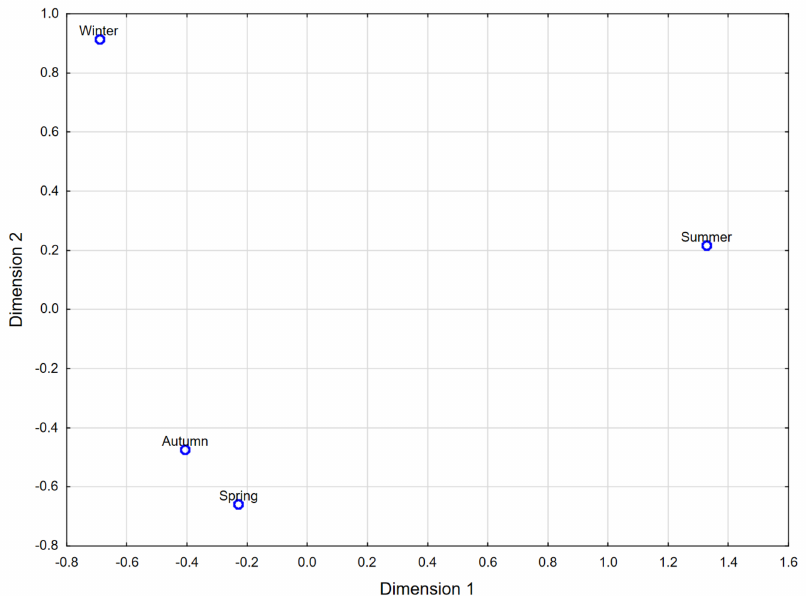
Figure 11. Results of multidimensional scaling for particular objects (seasons), taking into account all characteristics (parameters of tap water supplied in Poland and Ukraine).